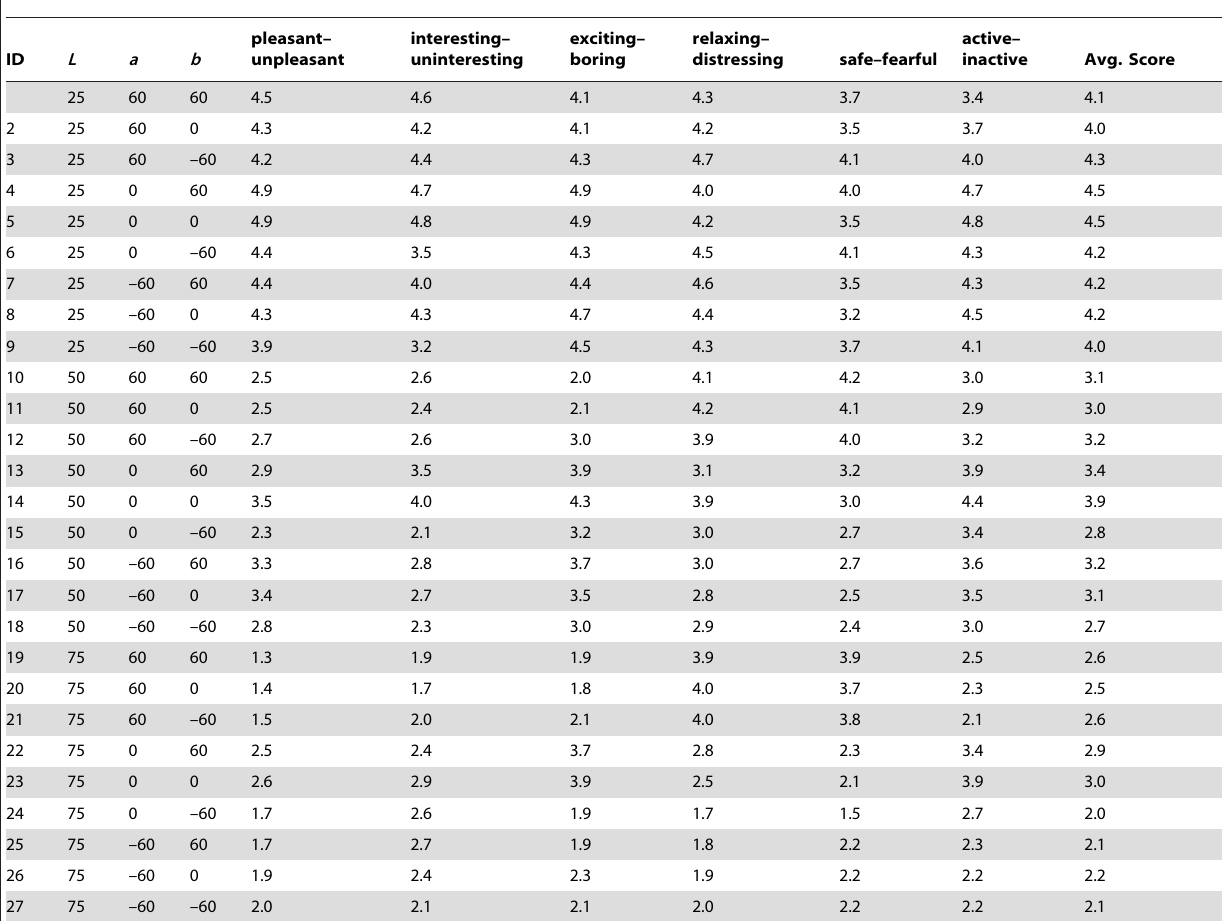
Table 1 . Experiment 1: Results of color sample